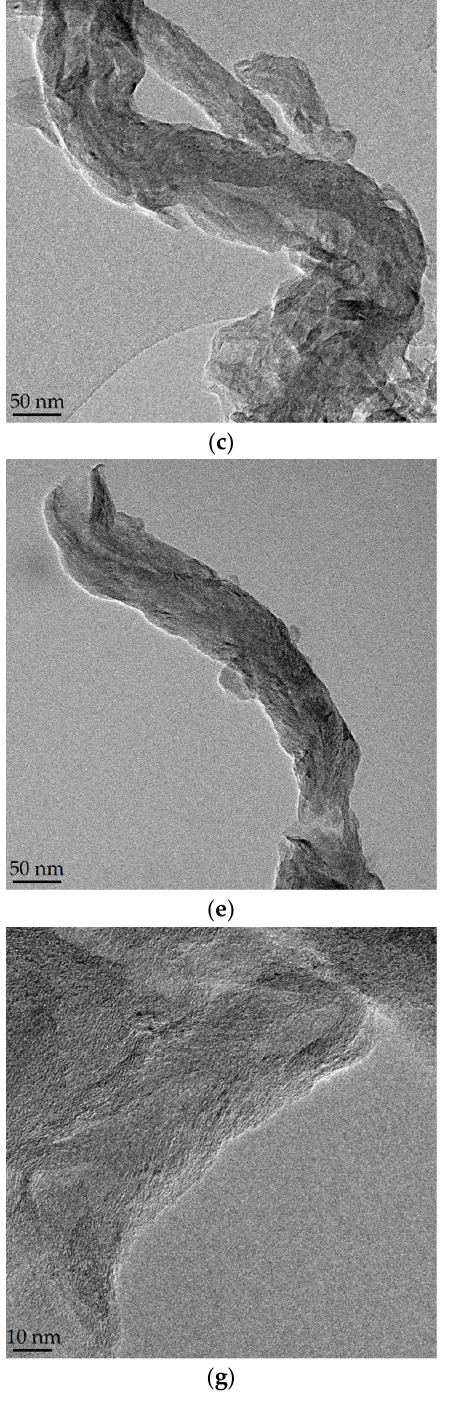
Figure 1. TEM images of: ( a , b ) graphene oxide nanofibers (GONF); and reduced GONFs (RGONFs) obtained at ( c , d ) 140, ( e , f ) 180, and ( g , h ) 220 °C. Height profile of graphene layers in a turbostratic stack is included in ( h ).